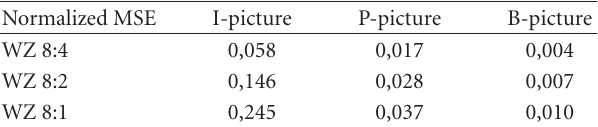
Table 3: Average distortion as a function of picture type. Normalized MSE